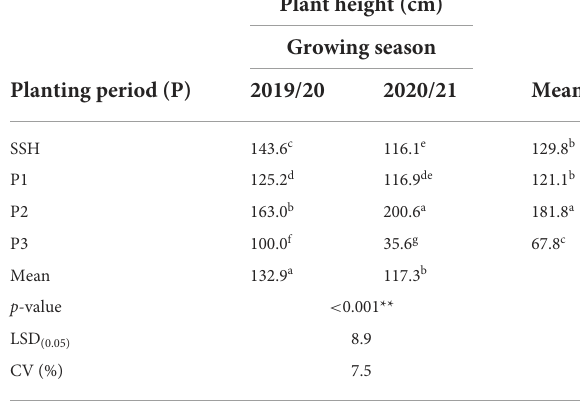
TABLE 2 Sunn hemp plant height as influenced by planting period (P) and growing season (S) under the in-field rainwater harvesting technique in the central semiarid area of the Free State Province, South